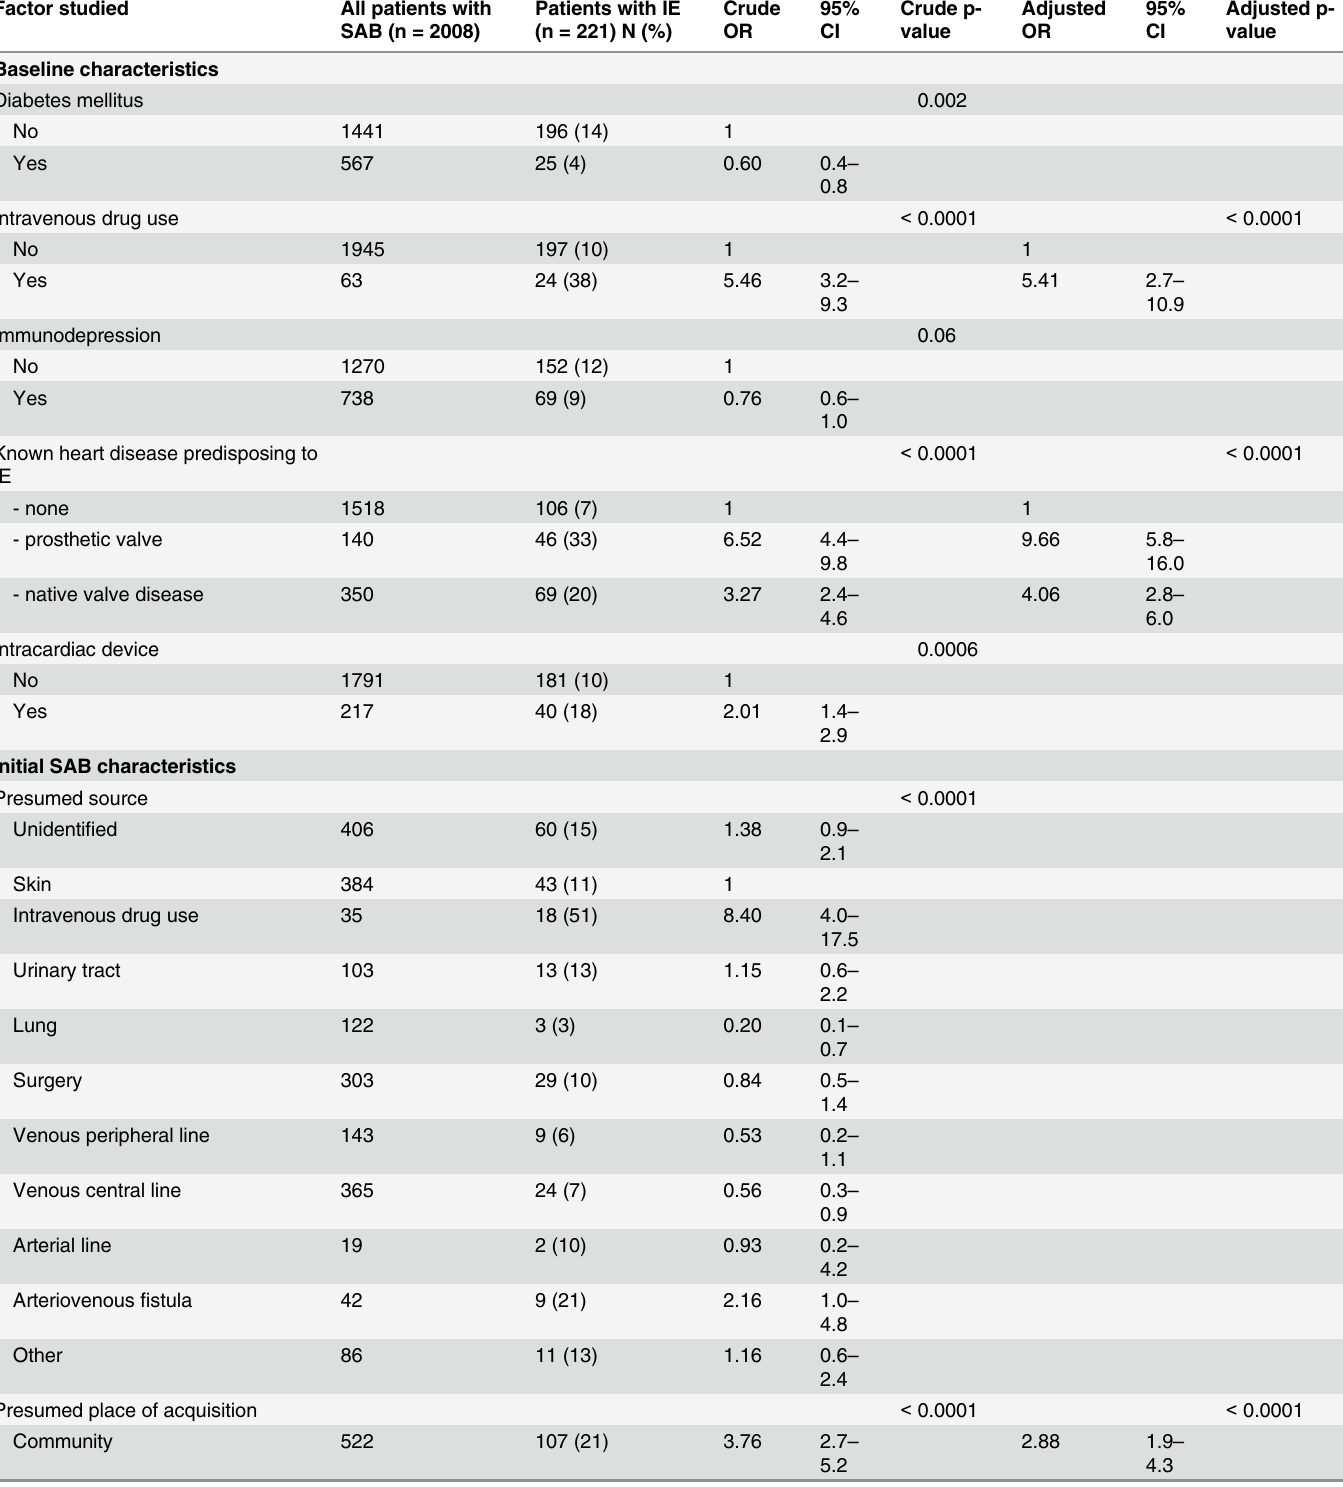
Table 4. Factors associated with Infective Endocarditis in the whole population, VIRSTA study 2009 –